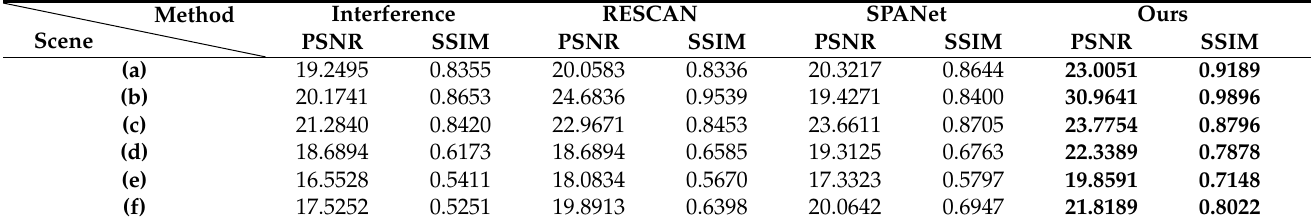
Table 4. Comparisons of SSIM and PSNR for measured